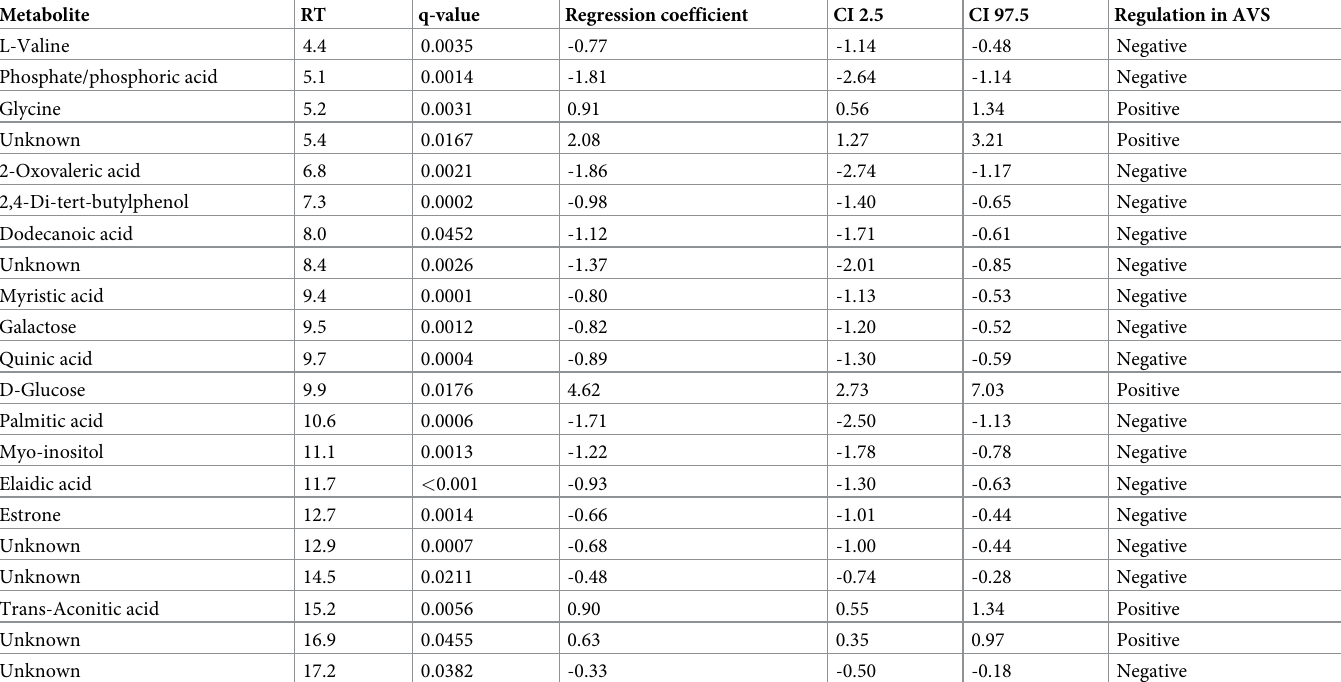
Table 3. Plasma metabolites contributing to the separation between the AVS patients and healthy